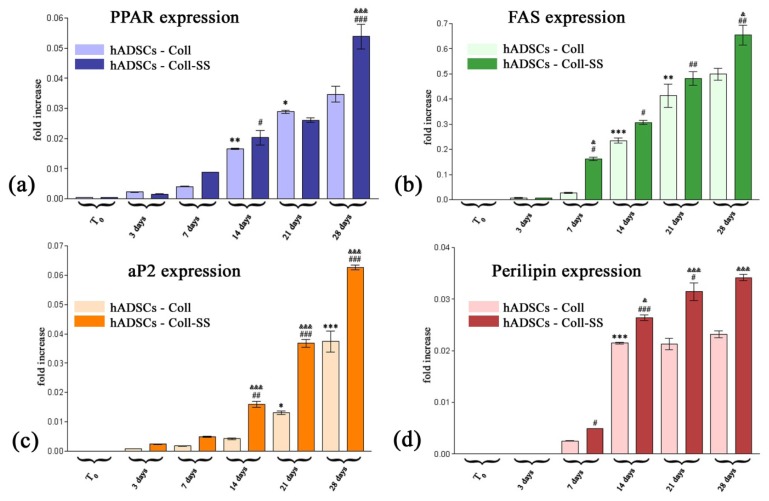
Gene expression profiles of (a) PPARγ2 (* p < 0.05 (Coll bioconstruct: 21 days vs. 14 days); ** p < 0.01 (Coll bioconstruct: 14 days vs. 7 days); # p < 0.05 (Coll-SS bioconstruct: 14 days vs. 7 days); ### p < 0.001 (Coll-SS bioconstruct: 28 days vs. 21 days); &&& p < 0.001 (Coll-SS bioconstruct vs. Coll bioconstruct: 28 days)). (b) FAS (** p < 0.01 (Coll bioconstruct: 21 days vs. 14 days); *** p < 0.001 (Coll bioconstruct: 14 days vs. 7 days); # p < 0.05 (Coll-SS bioconstruct: 7 days vs. 3 days and 14 days vs. 7 days); ## p < 0.01 (Coll-SS bioconstruct: 21 days vs. 14 days and 28 days vs. 21 days); & p < 0.05 (Coll-SS bioconstruct vs. Coll bioconstruct: 7 days and 28 days)). (c) aP2 (* p < 0.05 (Coll bioconstruct: 21 days vs. 14 days); *** p < 0.001 (Coll bioconstruct: 28 days vs. 21 days); ## p < 0.01 (Coll-SS bioconstruct: 14 days vs. 7 days); ### p < 0.001 (Coll-SS bioconstruct: 21 days vs. 14 days and 28 days vs. 21 days); &&& p < 0.001 (Coll-SS bioconstruct vs. Coll bioconstruct: 14 days, 21 days and 28 days)). And (d) perilipin (*** p < 0.001 (Coll bioconstruct: 14 days vs. 7 days); # p < 0.05 (Coll-SS bioconstruct: 7 days vs. 3 days and 21 days vs. 14 days); ### p < 0.001 (Coll-SS bioconstruct: 14 days vs. 7 days); & p < 0.05 (Coll-SS bioconstruct vs. Coll bioconstruct: 14 days); &&& p < 0.001 (Coll-SS bioconstruct vs. Coll bioconstruct: 21 days and 28 days)) as quantified by RealTime RT-PCR.